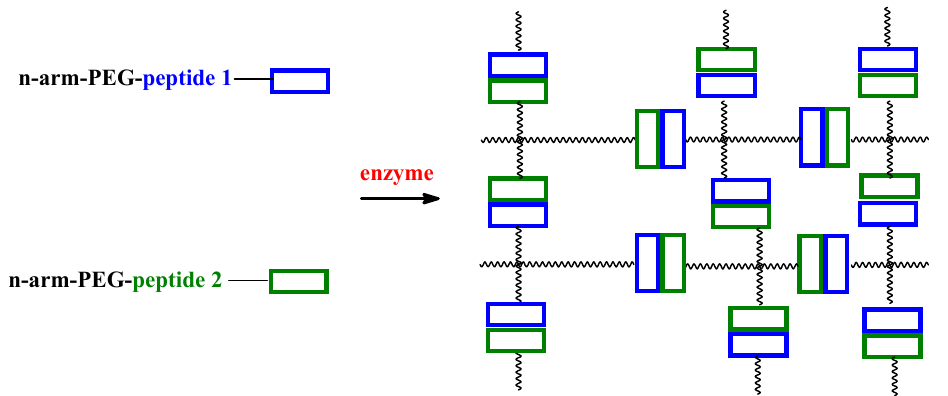
Figure 4. Enzyme-catalyzed hydrogel formation by cross-link two multiarm PEG-peptide conjugates.